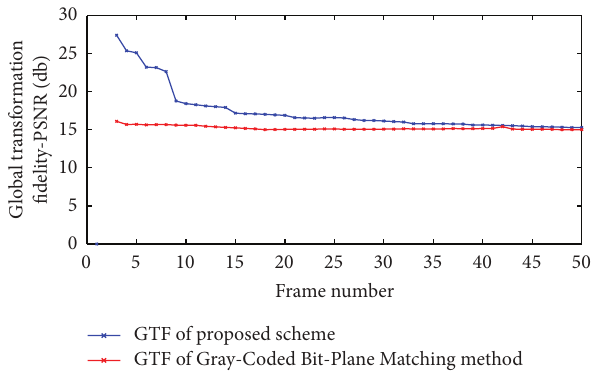
Figure 6: GTF of the video sequence “My Office,” measured by